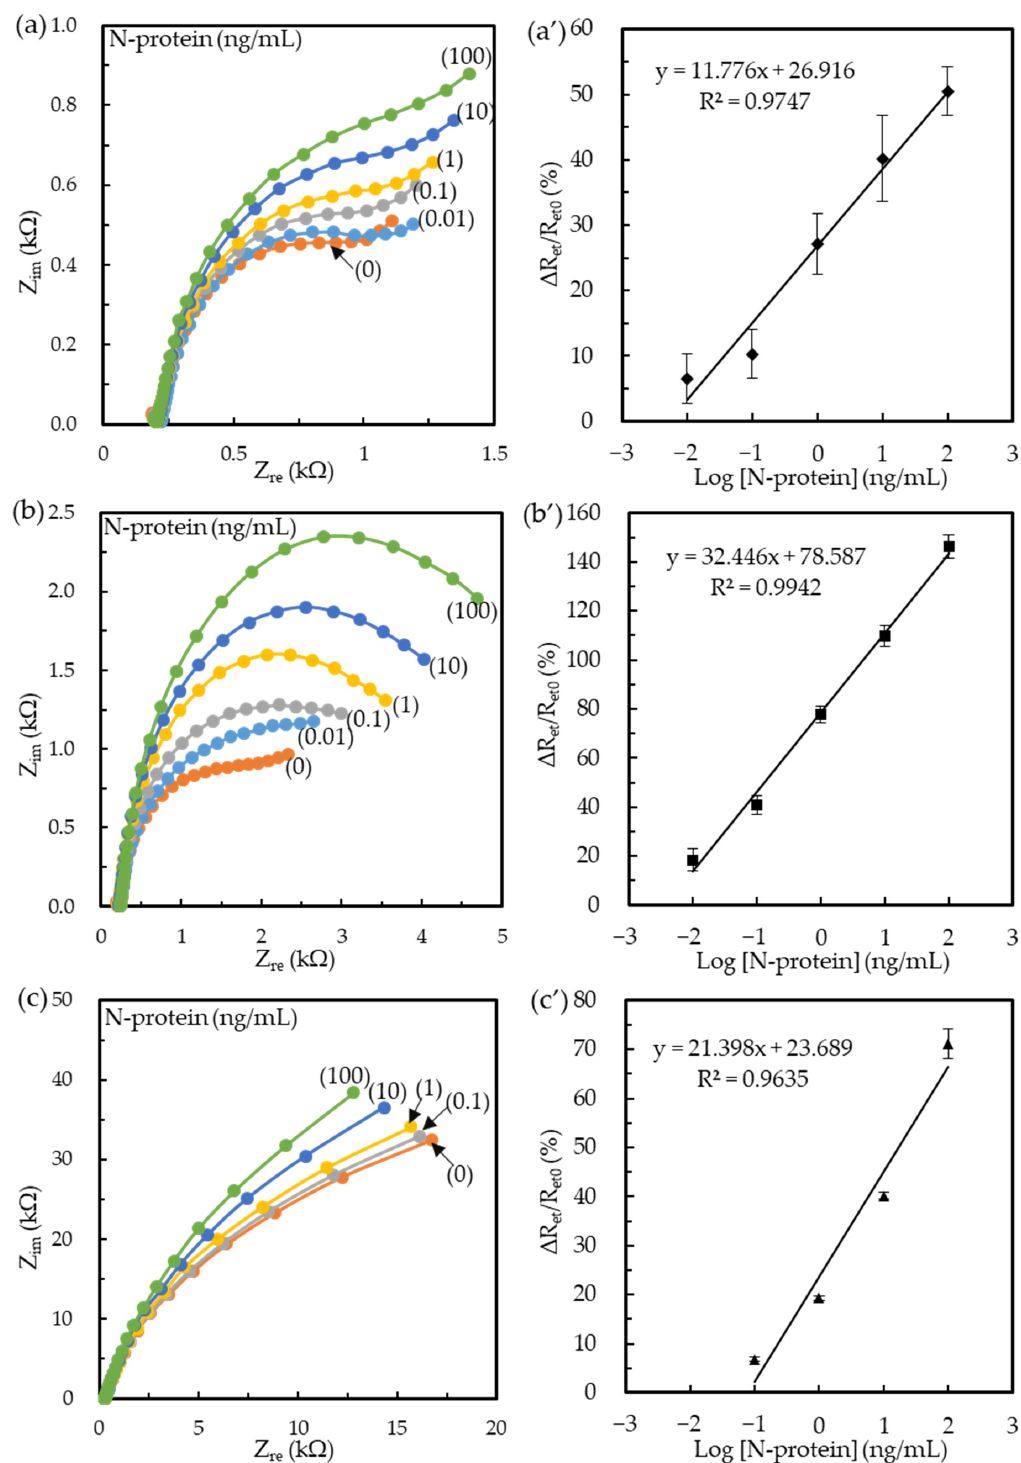
Figure 2. Nyquist plots of the ( a ) Ab/MPA/SPCE, ( b ) BioAb/SA-BSA/MPA/SPCE, and ( c ) BioAb/SA-BSA/MUA/SPCE-based immunosensors after sequentially immunoreacting with the N-protein samples of 0–100 ng/mL concentrations. Curves (i–vi) are 0 (i), 0.01 (ii), 0.1 (iii), 1 (iv), 10 (v), and 100 ng/mL (vi) N-protein, respectively. ( a’ – c’ ) The calibration curves corresponding to ( a – c ). ( n = 3).